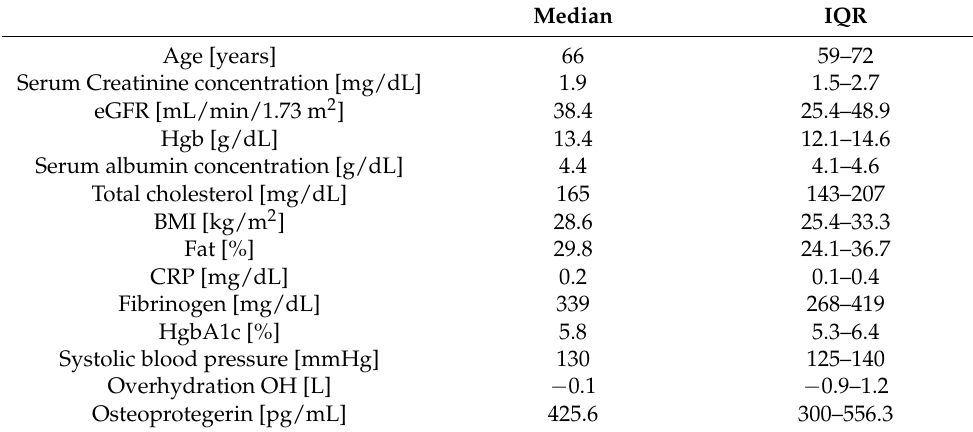
Table 1. Clinical characteristics of the study